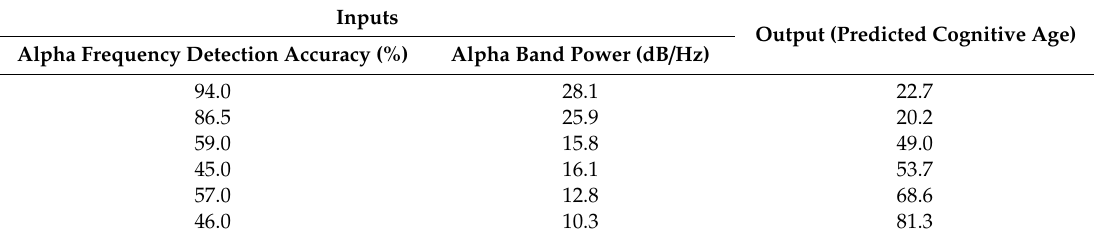
Table 5. Neural network predictions of cognitive age when given random frequency detection accuracies (alpha band, occipital region) and band power values as inputs.